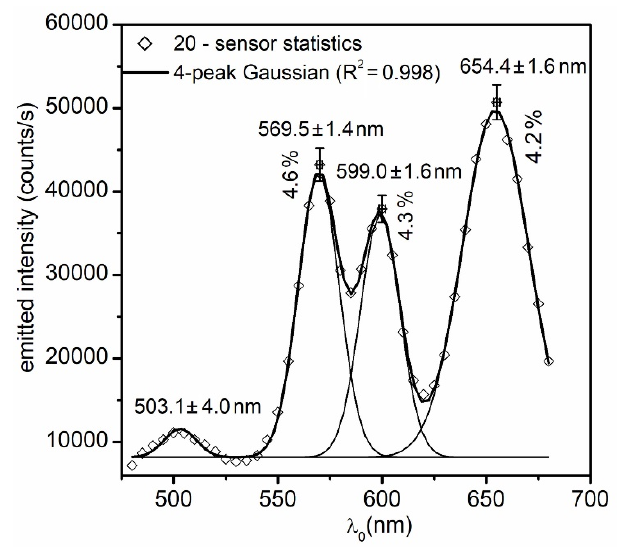
Figure 7. Reproducibility study over a population. ( ) experimental data comes from an average of 20 MSPRS spectra collected at 5 nm increments; ( thick continuous line ) A four-peak Gaussian statistical analysis of the experimental data; ( thin continuous lines ) Gaussian best fit of each MSPRS resonance in the experimental data; Error bars come from the four-peak Gaussian statistical analysis performed for each spectrum. Peak parameters were recorded and used to calculate experimental standard deviations in both wavelength and intensity.